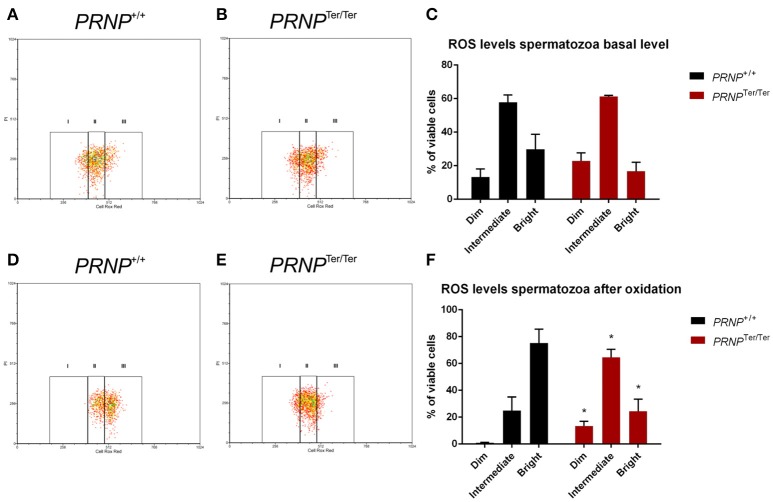
ROS levels in spermatozoa indicates no protection from PrPC. ROS levels were measured by flow cytometry in PRNP+/+ and PRNPTer/Ter spermatozoa after treatment with H2O2 and FeSO4 for 30 min. Plots from controls (A,B) and oxidized (C,D) spermatozoa are shown for both genotypes (A,D): PRNP+/+, (B,E): PRNPTer/Ter. Based on fluorescence intensity, spermatozoa were gated into regions dim, intermediate and bright, of which region bright represents spermatozoa with the highest ROS levels. Mean basal (C) ROS levels and mean ROS levels after H2O2 and FeSO4 treatment (F) in both genotypes is shown (n = 4). The percentages of viable cells before ROS exposure were 39.19 ± 4.98 and 37.75 ± 3.67 for PRNP+/+ and PRNPTer/Ter, respectively. The corresponding values after ROS exposure were 39.66 ± 3.69 (PRNP+/+) and 35.58 ± 3.67 (PRNPTer/Ter). Values are shown as mean ± SEM. *indicates p < 0.05 (Significance tested by multiple t-test with Holm-Sidak correction).